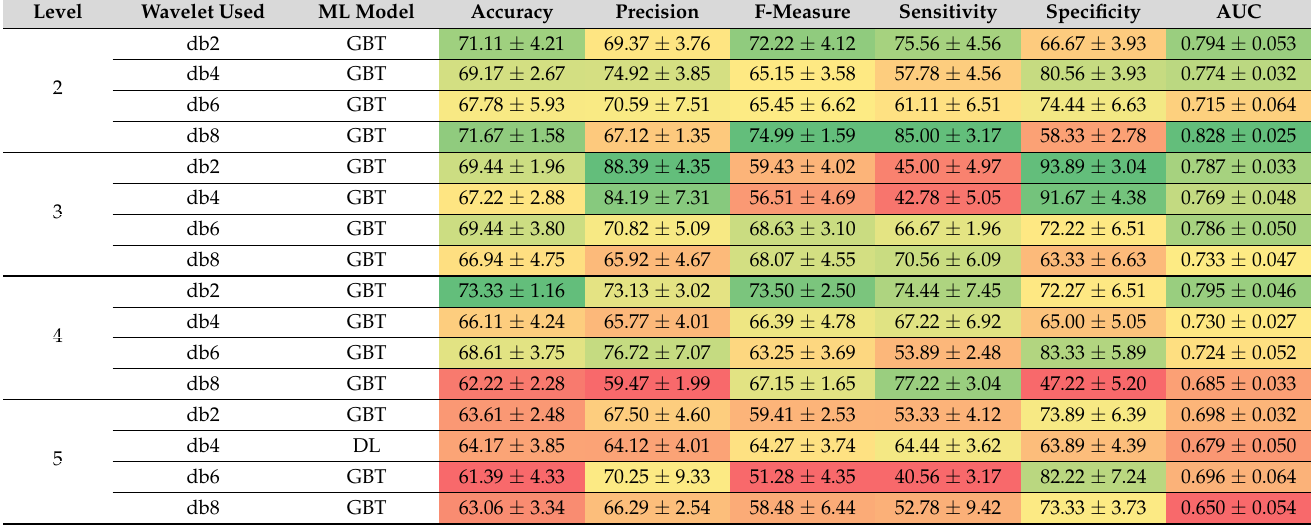
Table 3. Classification performance of the best ML models generated from the WPD-based processing of the ECG signals at different decomposition